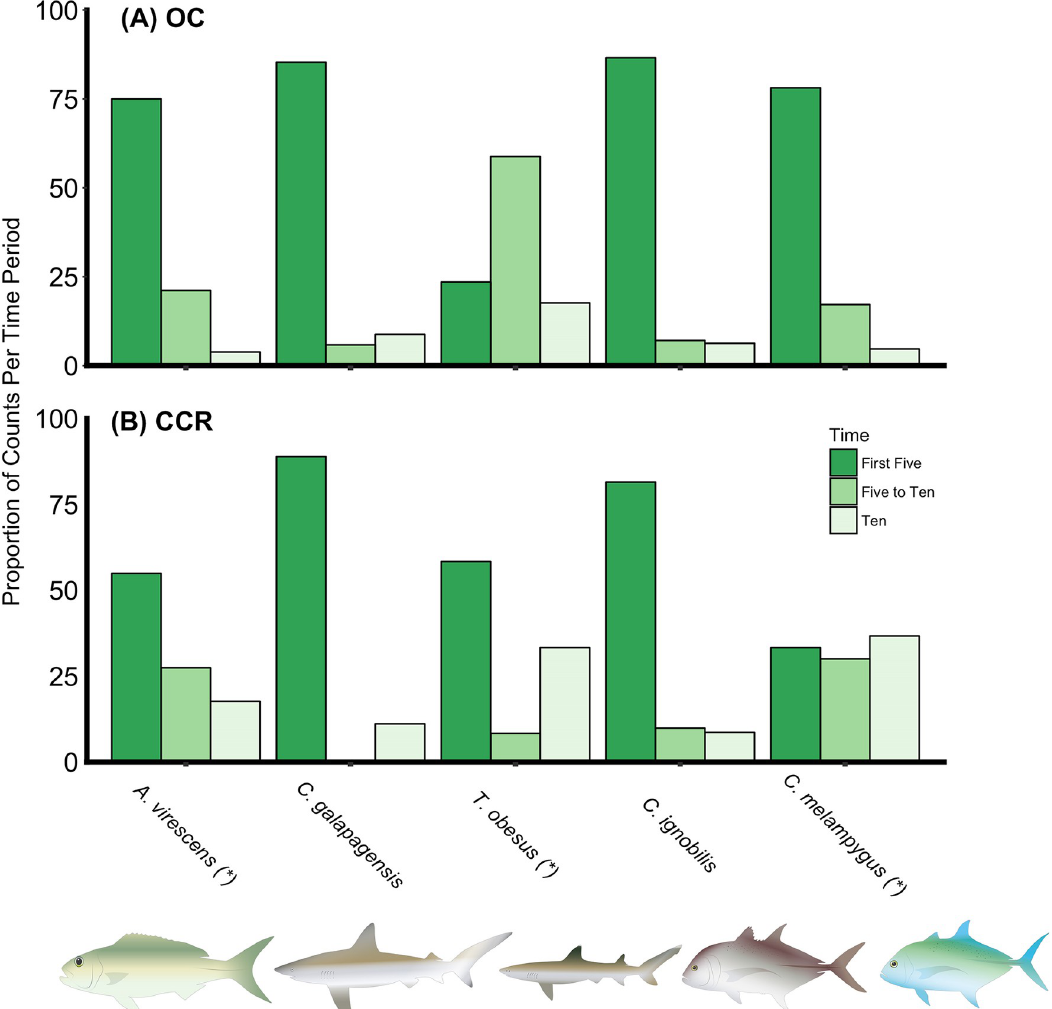
Fig 3. Distribution graph of the instance of first encounter. Survey periods in which roving piscivores were first recorded during open circuit (OC) and closed-circuit rebreather (CCR) surveys. Proportion of counts per time period are shown for 5 species of interest. Different colors represent the 3 time periods: “First Five” represents surveys in which the species was first recorded during the initial five minutes, “Five to Ten” for the second five-minute interval (5 to 10 minutes into survey), and “Ten” for the interval 10 to 30 minutes into the survey. Significant differences in distribution of first encounters between breathing apparatus are denoted by an asterisk ( � ) after the species